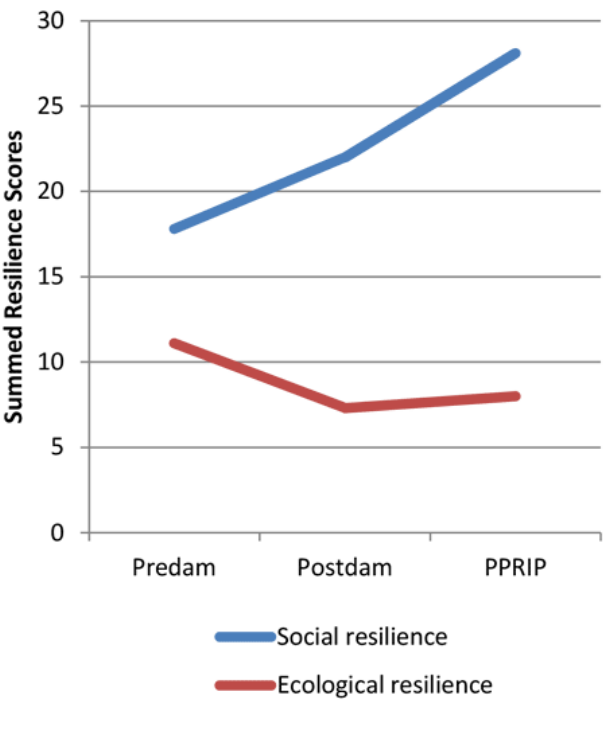
Fig. 5 . Social and ecological resilience of the central Platte River social-ecological system over the predam, postdam, and Platte River Recovery Implementation Program time periods, as described by summed resilience scores for all of the social and ecological resilience